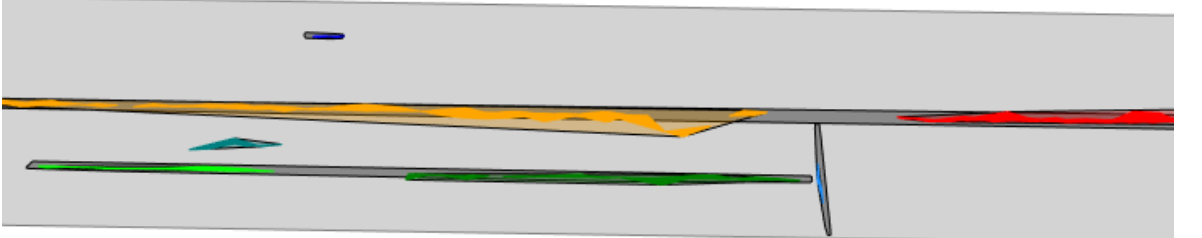
Figure 11. Road spot 1. Crack clusters detected with the proposed algorithm, delimited with both convex hulls ( light color ) and alpha-shapes ( dark color ). Boxes in grey delimit the manually segmented cracked areas.